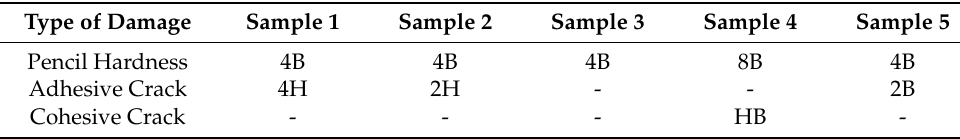
Figure 6. Results of lacquer hardness tests; ( a ) series 1, ( b ) series 2, ( c ) series 3, ( d ) series 4 and ( e ) series 5. Table 7. Pencil-hardness for individual